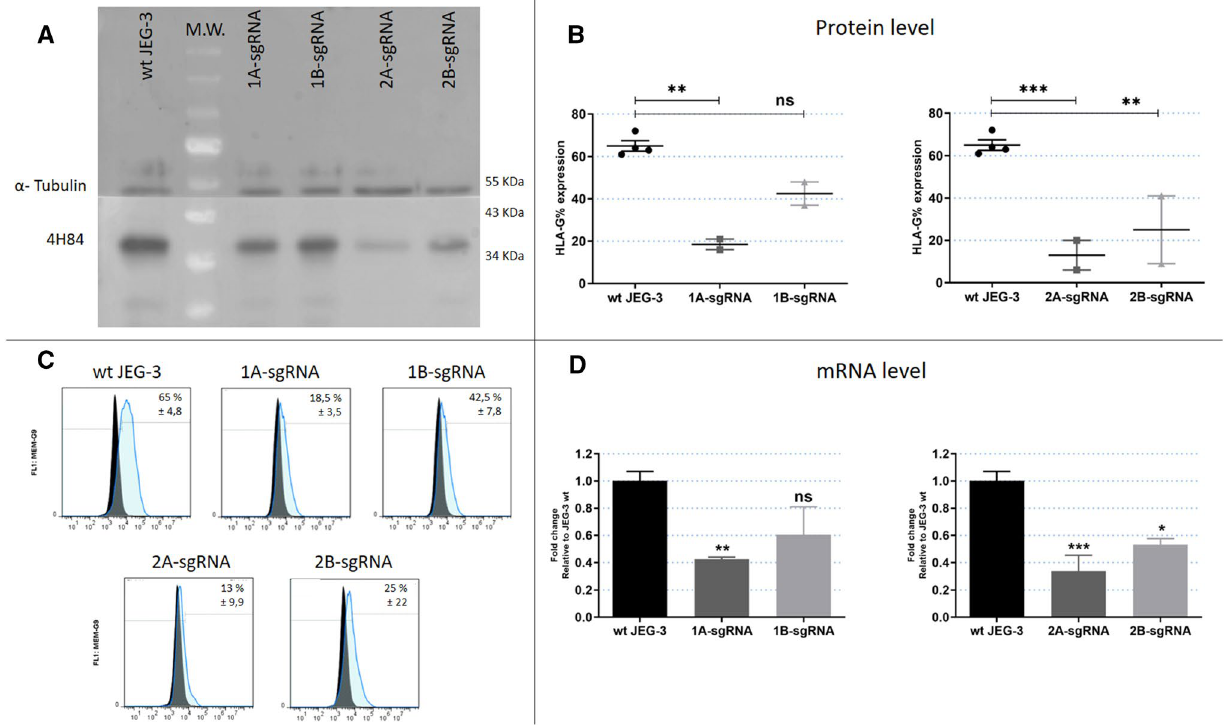
Figure 3. Analysis of JEG-3 edited cells by CRISPR/Cas9 with each sgRNA (1A-, 1B-, 2A- and 2B) ( A ) Western Blot analysis of HLA-G expression in JEG-3 edited cells (right) and wild type JEG-3 (left). ( B ) Protein expression measured by flow cytometry. ( C ) Representative histograms of HLA-G measured by flow cytometry. Isotype control is shown in black. ( D ) The HLA-G mRNA expression measured by RT-qPCR. No significant: ns. Significant differences are shown with * ( p <